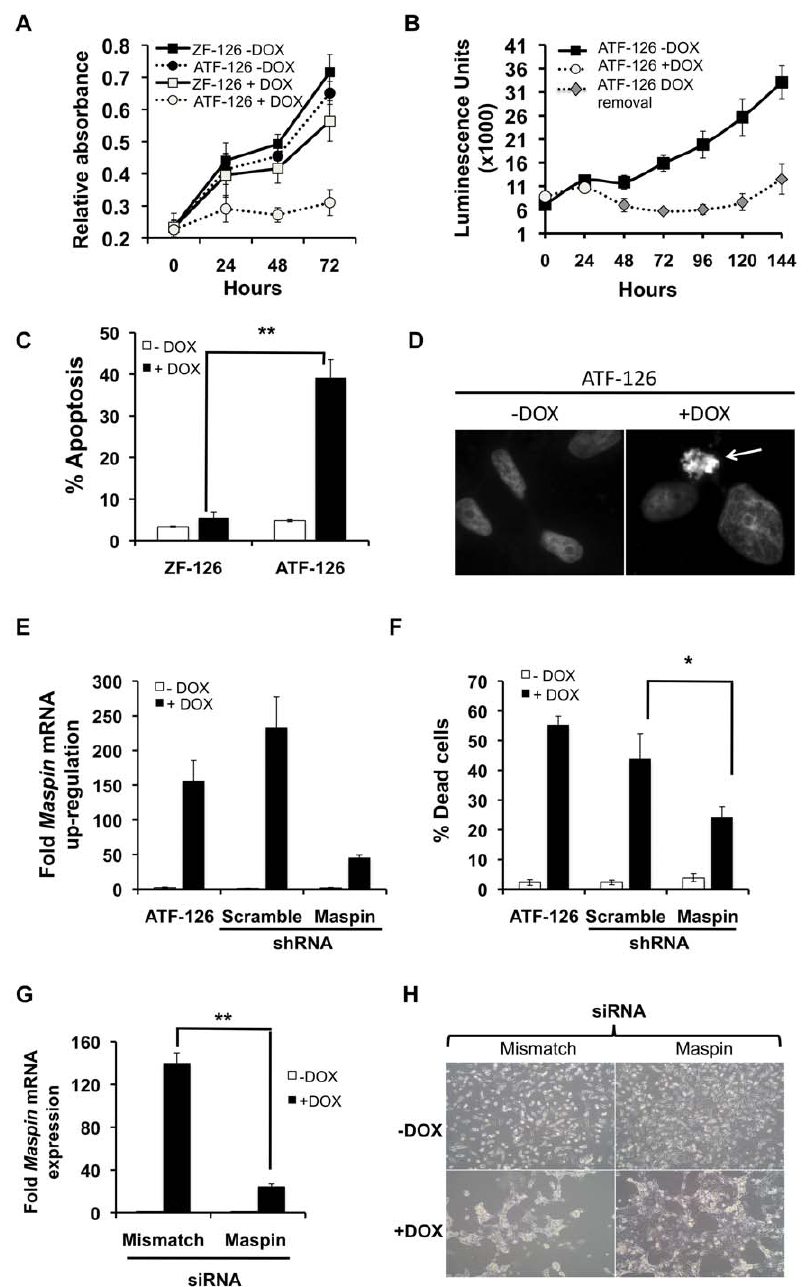
Figure 2. ATF-126 induced apoptosis upon DOX treatment. A. Cell viability plot of ATF-126 and ZF-126 cells treated with vehicle ( 2 DOX) or DOX ( + DOX) for 72 hours. ATF-126 refers to a full length, active ATF and ZF-126 is a truncated, transcriptionally inactive construct lacking the VP64 activator domain. B. Cell viability plot of ATF-126 transduced cells after DOX removal. Cells were induced with DOX for 48 hours (open circles). DOX was removed from the media and cells were kept in DOX-free media for an additional period of 96 hours. Viability of ATF-126 cells growing in absence of DOX ( 2 DOX, filled squares) was plotted as reference control. Cell viability was measured with an XTT assay [12]. C. ATF-126 induced apoptosis upon DOX treatment. Either ATF-126 or ZF-126 cells were kept in vehicle-treated media ( 2 DOX) or DOX ( + DOX) and collected at 72 hours after induction. The percentage of apoptosis was quantitatively analyzed using an Annexin-V staining [12]. D. Hoechst staining of ATF-126 2 DOX and + DOX cells at 72 hours post-induction. Arrow points to a positive apoptotic cell, showing nuclear condensation. E. Expression of Maspin by qRT-PCR in ATF-126 cells retrovirally transduced with either a scramble or with a Maspin -specific shRNA construct. F. Percentage of cell death by trypan-blue exclusion assay in ATF-126 cells transduced with either a scramble or a Maspin -specific shRNA. G. Maspin expression as assessed by qRT-PCR in ATF- 126 cells transfected with either a mismatch or a Maspin -specific siRNA, and treated with vehicle ( 2 DOX) or DOX ( + DOX). H. Representative pictures of the Maspin siRNA knock-down experiments of cells treated with vehicle ( 2 DOX) or DOX ( + DOX). Bar graphs in C, E, F and G represent the average of 3 independent experiments. Differences between samples were calculated with a student t test with level of significance *p # 0.05 and ** p # 0.01.